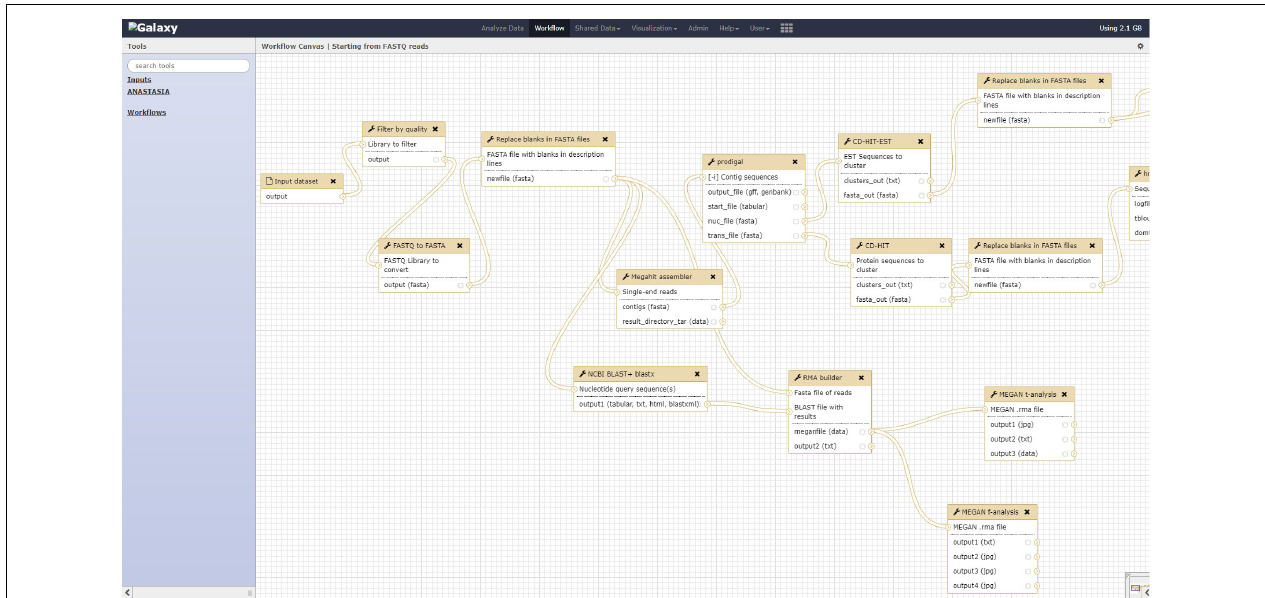
FIGURE 3 | Galaxy’s Workflow